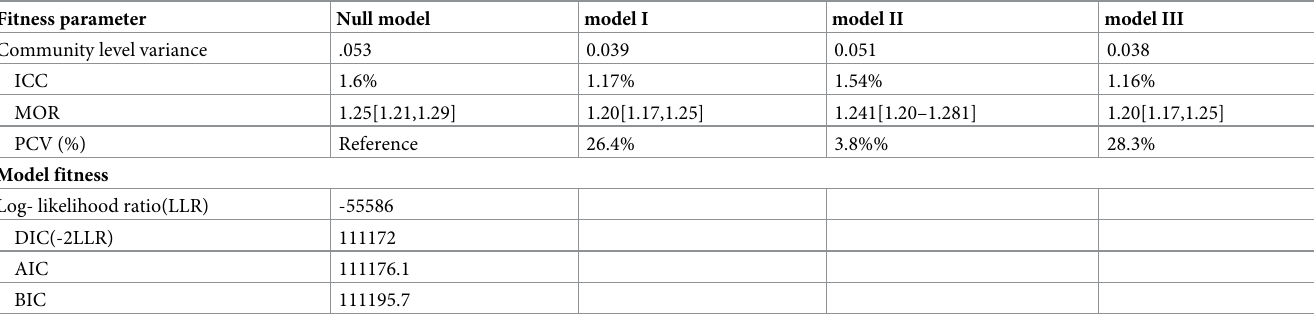
Table 4. Model comparison and fitness parameter outputs.